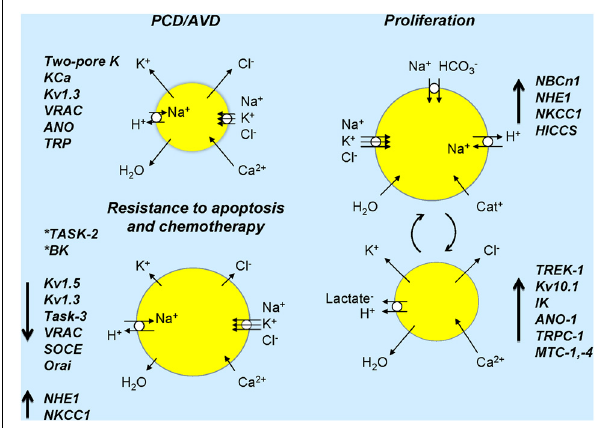
FIGURE 2 | Ion channels and transporters and cell volume changes associated in normal and cancer cells. Cell sizes refer to expected cell volume changes and lengths of arrows on cells indicates up- or down-regulation or ion transporters/channels. Resistance to apoptosis is associated with down-regulation of several channels and inhibition of some channels (asterisks) induces resistance to apoptosis. In proliferation, several transporters and channels are up-regulated and over-expressed in cancer (see text). The right part of the figure shows ion transporters and channels that would lead to cell volume increase and those in the lower part indicate those that would lead to cell volume decrease. Large arrows next to named ion channels/transporters indicate their up- or down-regulation in cancer. Chronic activation of ion transport may lead to cell death. Dynamic activation or suppression of ion transport/cell volume with specific signals, in time or in given cells may lead to cancer development and